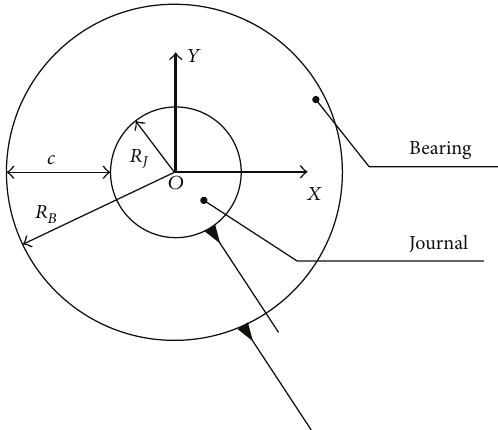
Figure 3: Schematic diagram of revolute joint with clearance.